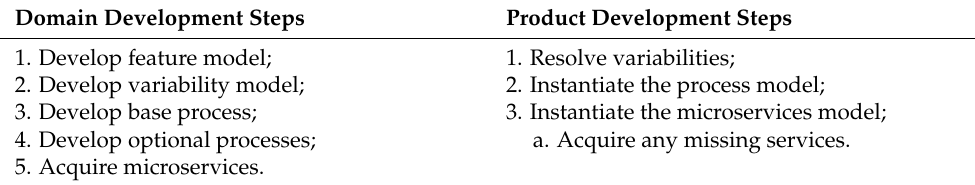
Table 2. Domain and product development